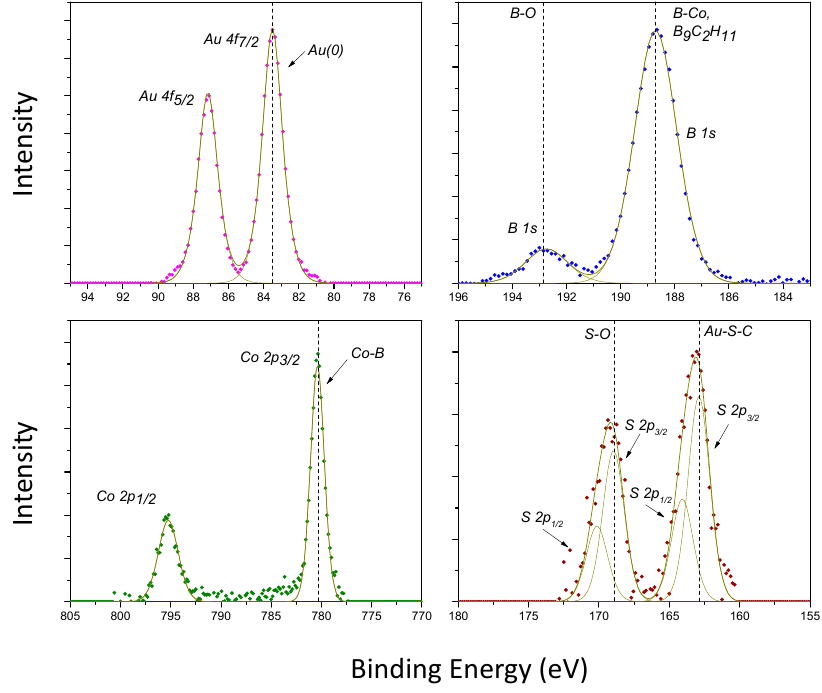
Figure 2. XPS spectra of PEG-AuNPs@[ 4 ] − .